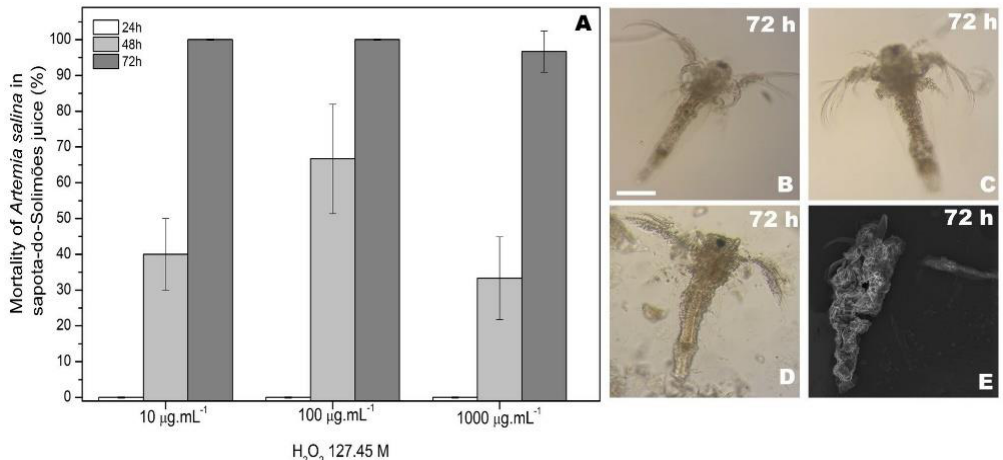
Figure 4. Protective effect of unprocessed sapota-do-Solimões in the 24/48/72 h interval against H 2 O 2 using Artemia salina nauplii ( A ) . Morphological changes in the Artemia salina nauplii after 72 h of exposure under optical microscopy unprocessed sapota-do-Solimões 10 µg·mL −1 ( B ), unprocessed sapota-do-Solimões 100 µg·mL −1 ( C ), unprocessed sapota-do-Solimões 1000 µg·mL −1 ( D ). Morphological changes in the Artemia salina nauplii by scanning electron microscopy unprocessed sapota-do-Solimões 1000 µg·mL −1 ( E ). Bars, 200 µm.